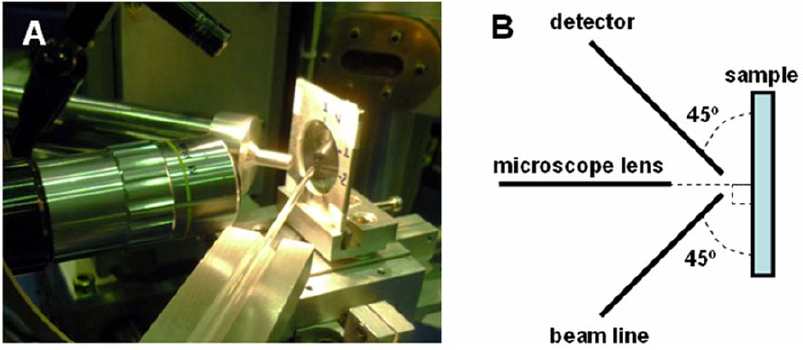
Figure 2. Beamline geometry. A) XRF line set up at the LNLS. B) Beamline geometry (view from the top).